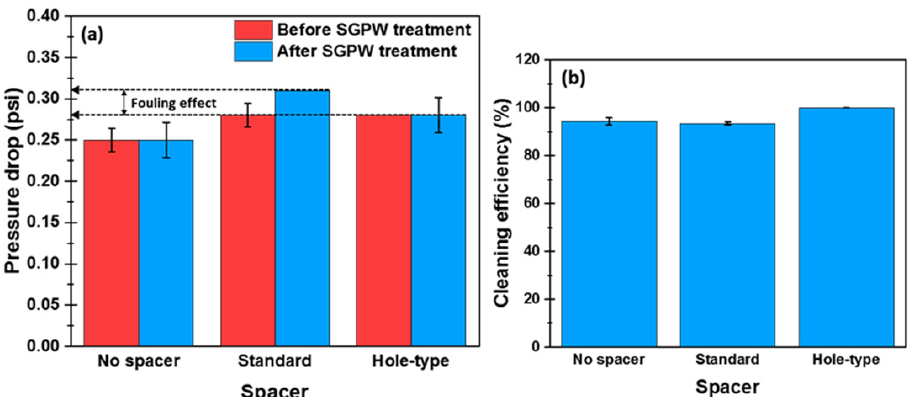
Figure 7. ( a ) Pressure drop measured along the feed filtration channel before and after SGPW treatment, and ( b ) physical cleaning efficiency applied by increasing the inlet cross-flow velocity three times higher than the velocity used throughout the experiments. The cleaning efficiency was calculated based on Equation (11).